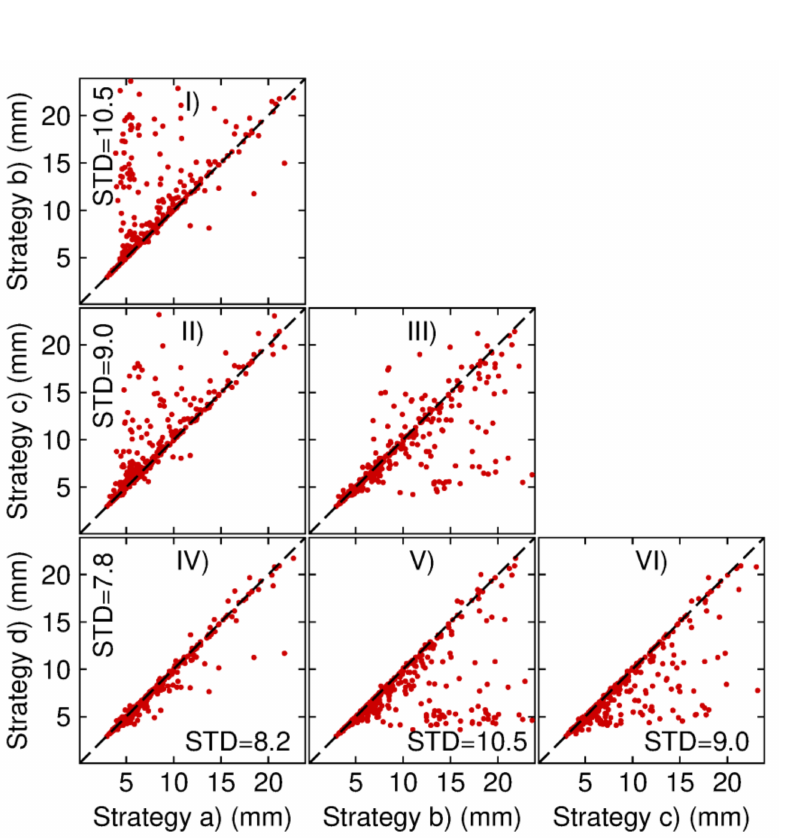
Figure 6. Ambiguity-fixed mean standard deviations of position errors comparison in the east direction between the daily kinematic PPP-AR solutions based on strategies (a), (b), (c) and (d). For I-VI panels, each panel denotes the comparison of two strategies. Each red dot denotes a station. The standard deviations along the horizontal and vertical axes are the mean values of all